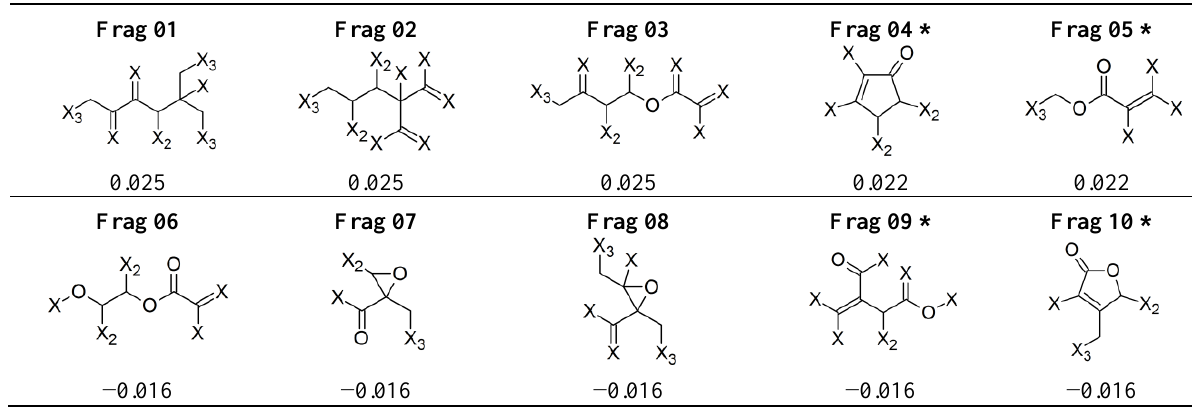
Table 4. List of fragments with highest positive and negative contribution to Tbr HQSAR model; X atoms are the connectivity flag and are not considered part of